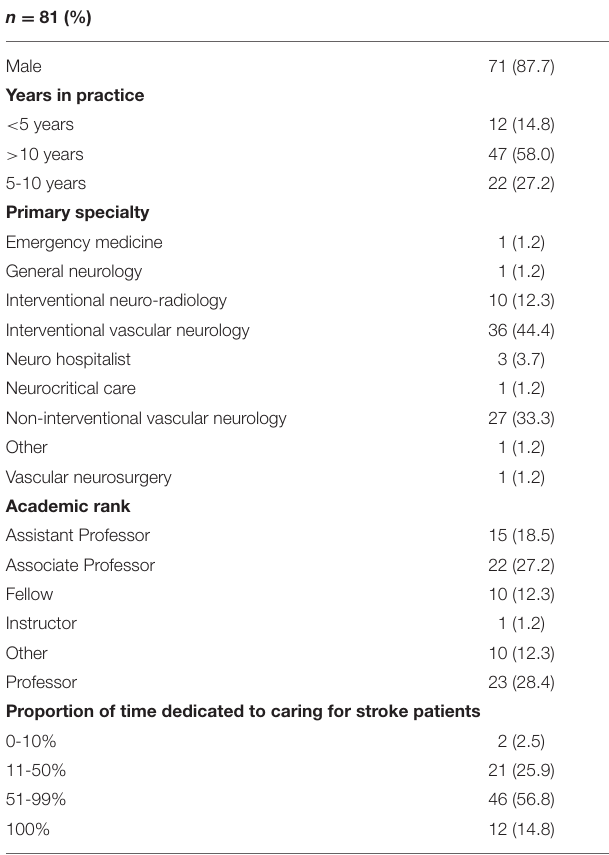
TABLE 1 | Demographics of survey